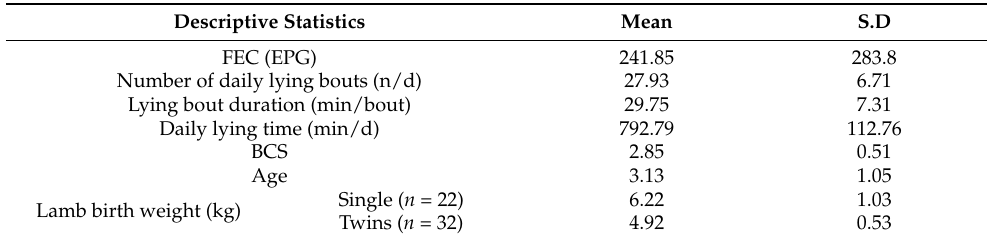
Table 1. Means and standard deviations of parasitological, behavioural and general measurements recorded during